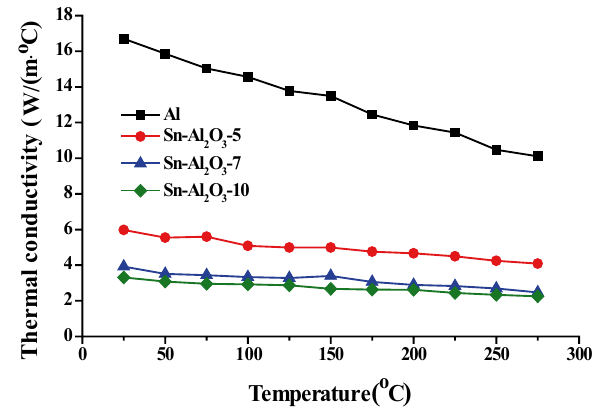
Fig. 6 Temperature dependences of thermal conductivity of non-ano- dized Al and Sn–Al 2 O 3 with different Sn contents